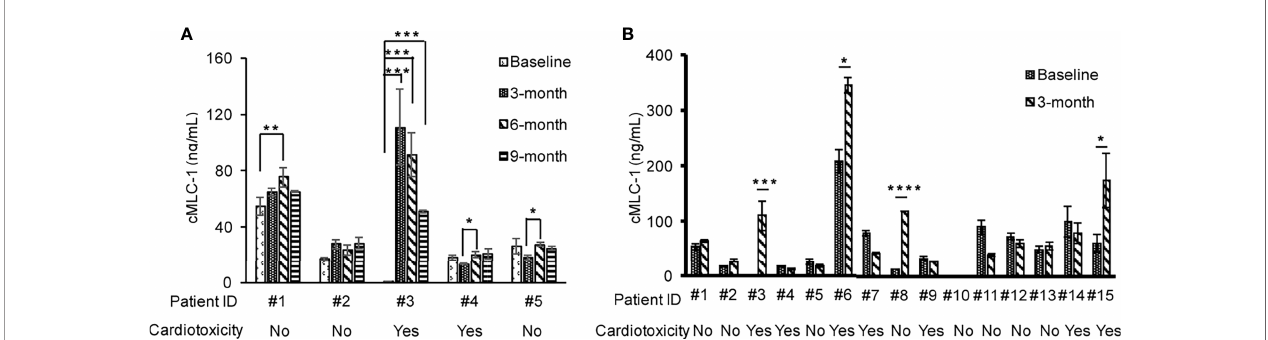
FIGURE 1 | Pro fi le of plasma cMLC-1 levels in trastuzumab-treated breast cancer patients with or without cardiotoxicity. Plasma samples were collected at multiple time points as indicated. Each plasma sample was diluted 1:10 and tested in duplicate to determine cMLC-1 concentration by ELISA. The mean ± SD of cMLC-1 in each sample is shown. Baseline: before trastuzumab treatment; 3, 6 and 9 months: time points after trastuzumab treatment (A) . A total of 15 paired-plasma samples collected at before (baseline) and after 3-months trastuzumab treatment were measured for cMLC-1 (B) . The mean ± SD of cMLC-1 in each sample is shown. The paired Student -t test was used to analyze the differences. * p <0.05; ** p < 0.01; *** p < 0.005 and **** p